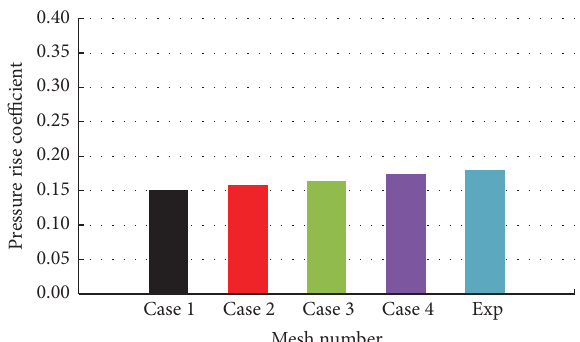
Figure 3: The grid independent check for the head of the inducer under 90% of the design point ( Φ = 0.05903